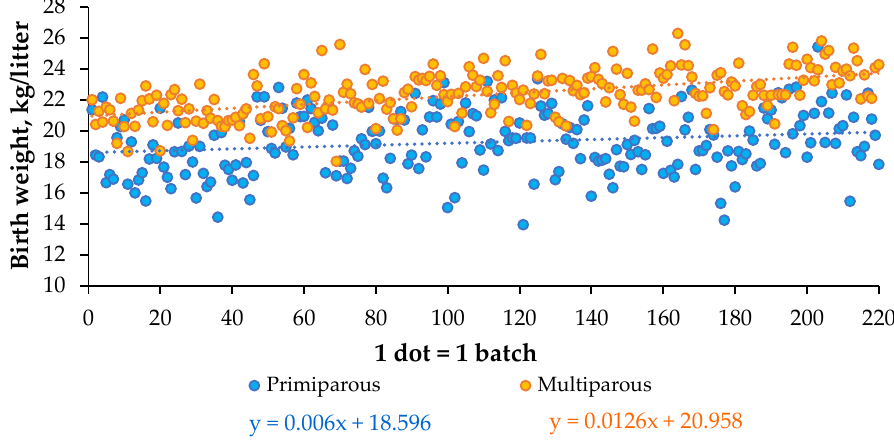
Figure 3. Mean birthweight (kg/litter) obtained per batch from primiparous and multiparous sows in 220 batches from reproductive cycles 20–56.